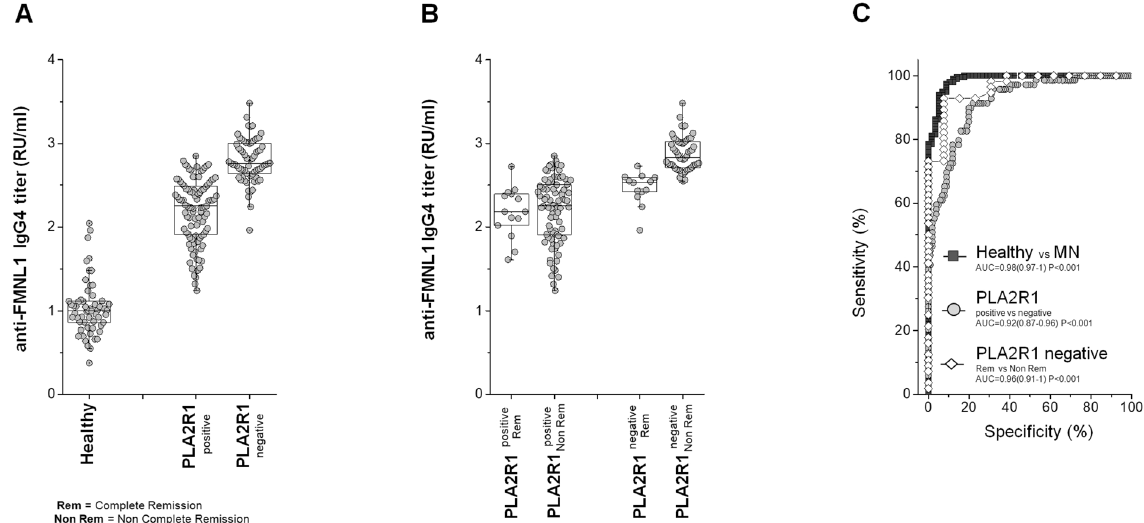
Figure 3. ELISA assay for anti-FMNL1 serum levels in patients with MN. ( A ) Box plot showing the median and interquartile range value of serum for anti-FMNL1 in all subjects of study. Anti-FMNL1 was statistically significant more abundant in MN patientsanti-PLA2R1 negative compared to healthy donors and MN anti- PLA2R1 positive ( P < 0.0001). ( B ) Box plot of serum anti-FMNL1 in MN patients stratified in function of anti-PLA2R1 positivity and their range of proteinuria after one year from hospitalization (< 0.3 g/d complete remission; > 0.3 g/d no complete remission). Anti-FMNL1 was statistically significant more abundant in MN patients anti-PLA2R1 negative in no complete remission compared with all other MN patients ( P < 0.0001). Moreover, no difference was present in anti-FMNL1 titer between MN patients anti-PLA2R1 positive in complete remission or not and anti-PLA2R1 negative in complete remission. ( C ) ROC curve analysis for FMNL1 assay.